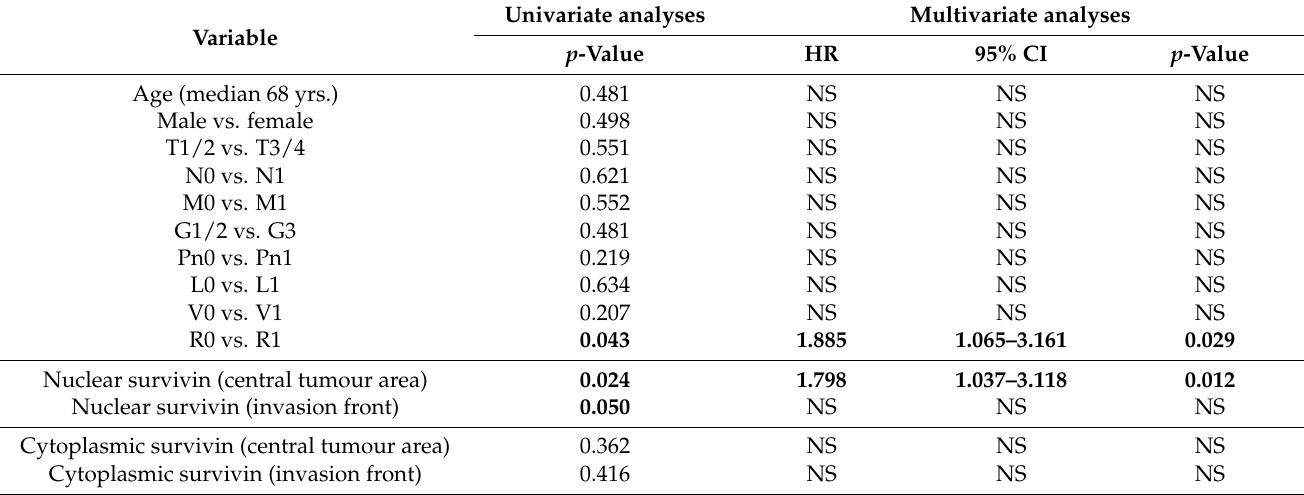
Table 7. Disease-free survival analysis 1